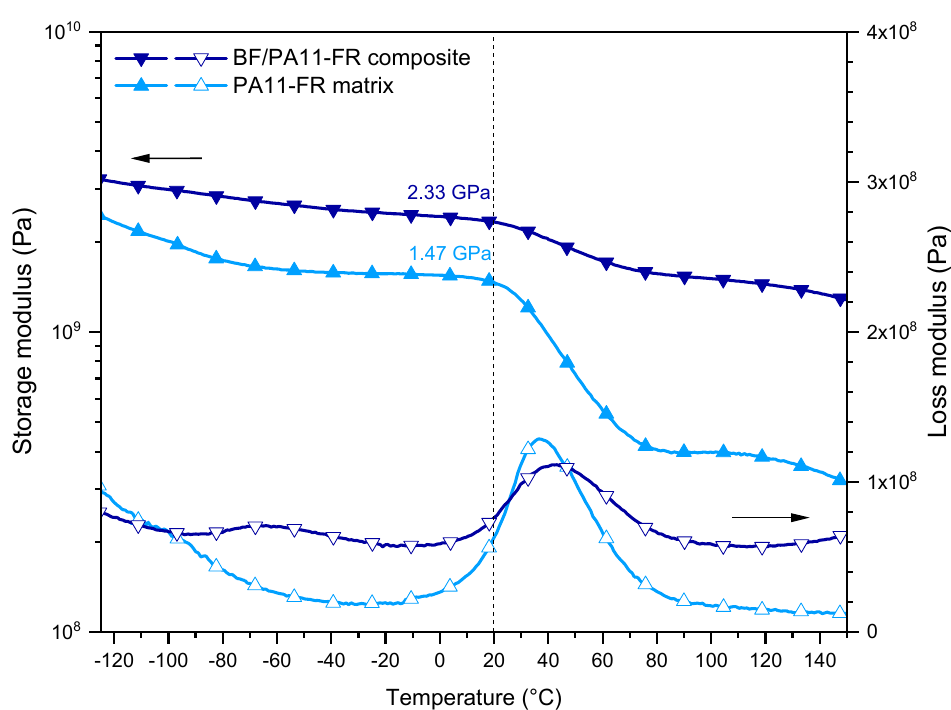
Figure 5. DMA curves in shear mode of PA11-FR matrix and BF/PA11-FR composite. Shear Storage